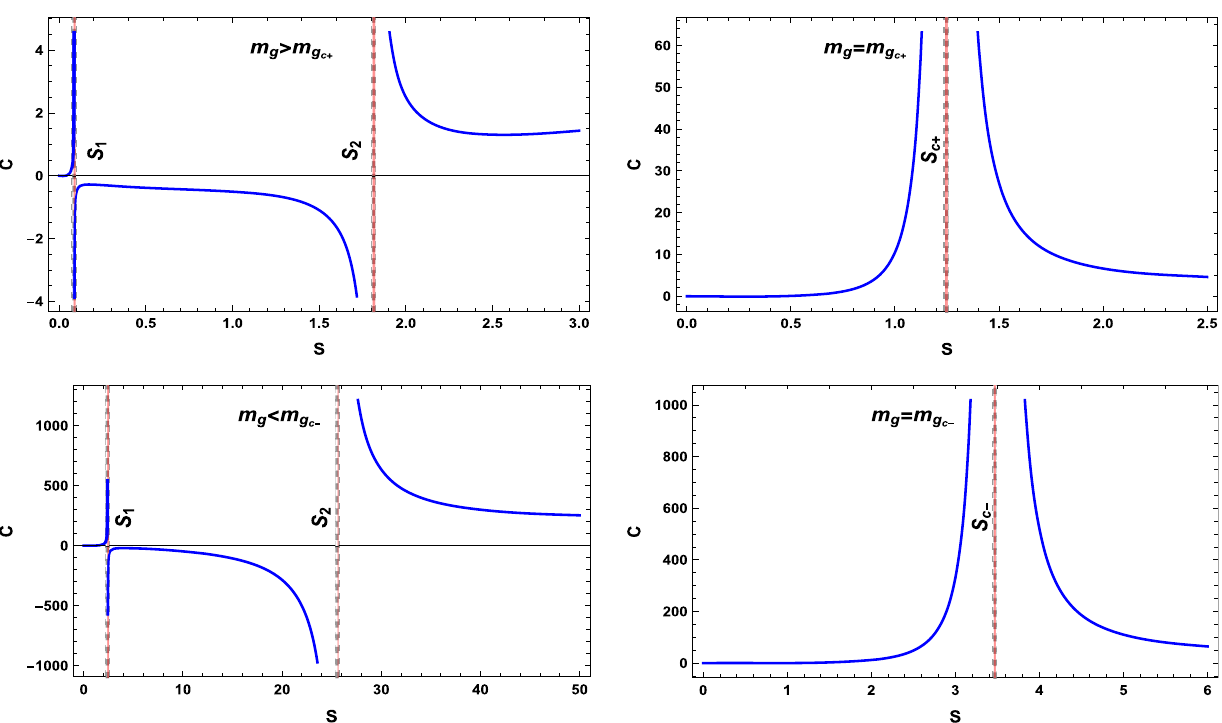
Fig. 6 Canonical ensemble: the heat capacity as a function of the entropy for the charged BH where m g > m g with Q = 0 . 5 , c = 1 , α = 1 and β = 2. The dashed lines correspond to the divergency points of C Q , m